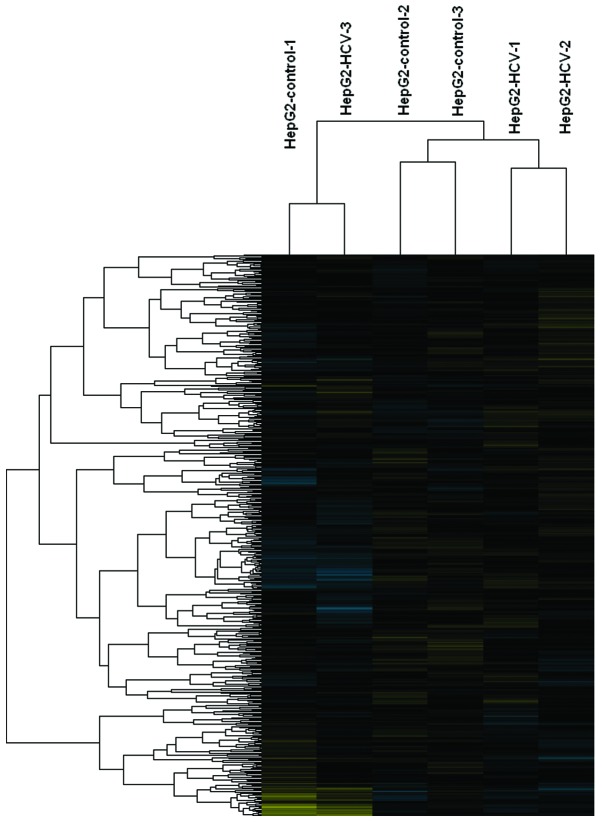
Expression profile of microRNAs in HepG2-hepatitis C virus and HepG2-control cells.